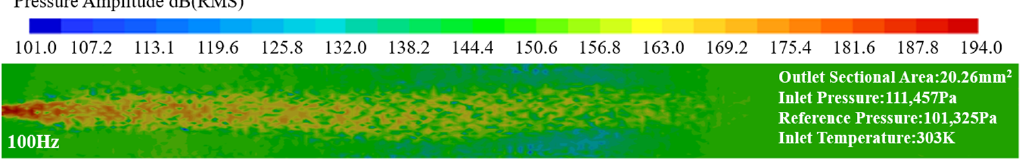
Figure 15. Cloud map of the 100 Hz near-field sound pressure levels of the equal-diameter